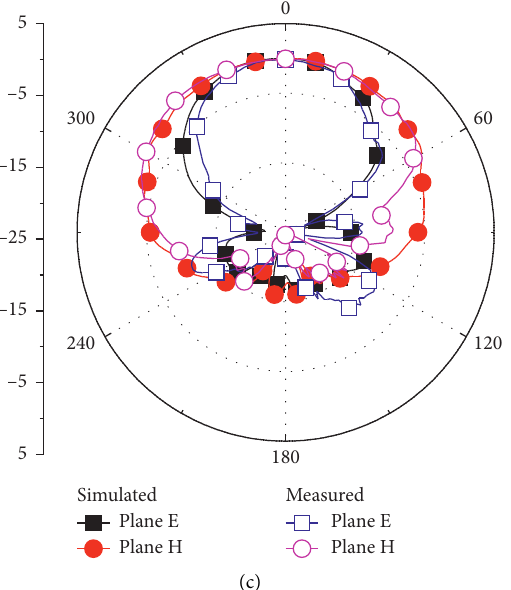
Figure 12: Simulated and measured radiation patterns of the designed quasi- Yagi antenna. (a) Reference quasi-Yagi antenna (90 mm). (b) Compact rectangle quasi-Yagi antenna (65 mm). (c) Compact trapezoid quasi-Yagi antenna (30mm).